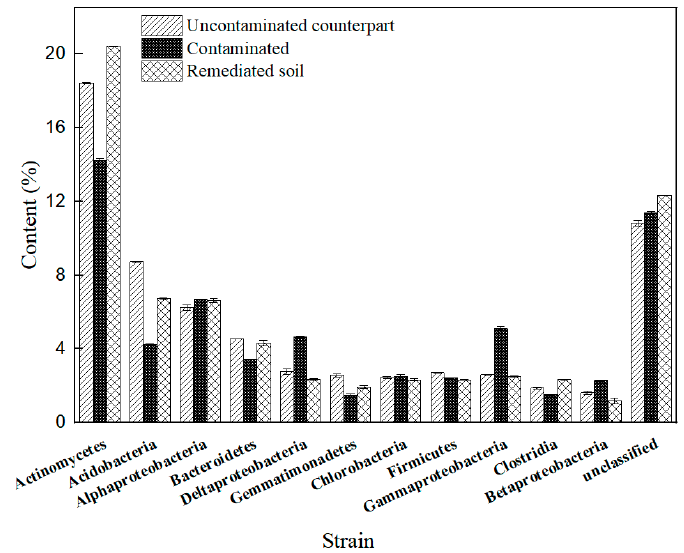
Figure 7. The microbial community of the soil samples.